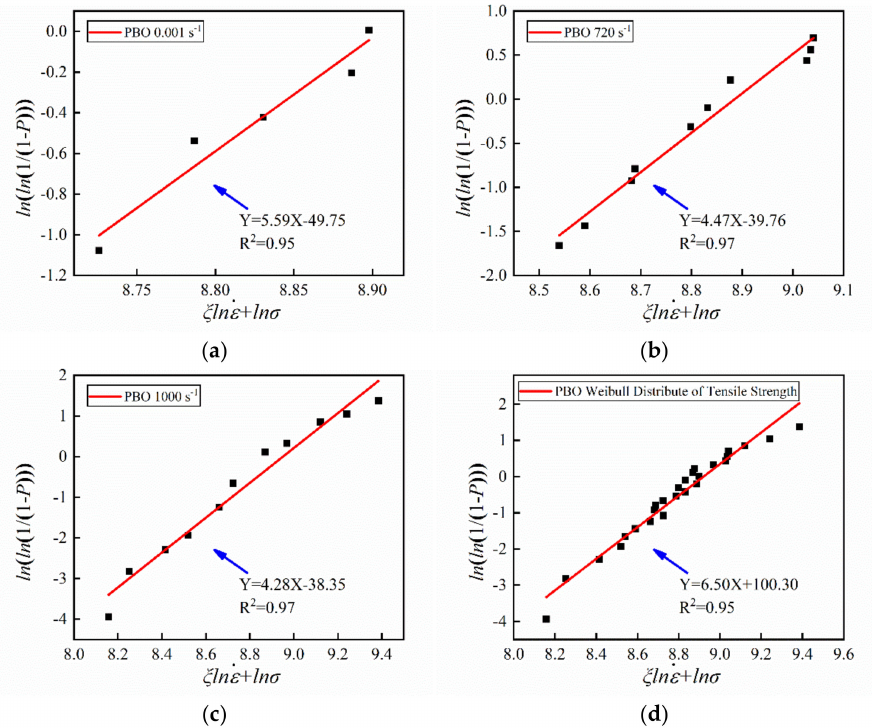
Figure 7. Weibull distribution of single PBO fibers with strain rate at ( a ) 0.001 s − 1 , ( b ) 720 s − 1 , ( c ) 1000 s − 1 , and ( d ) the whole range.